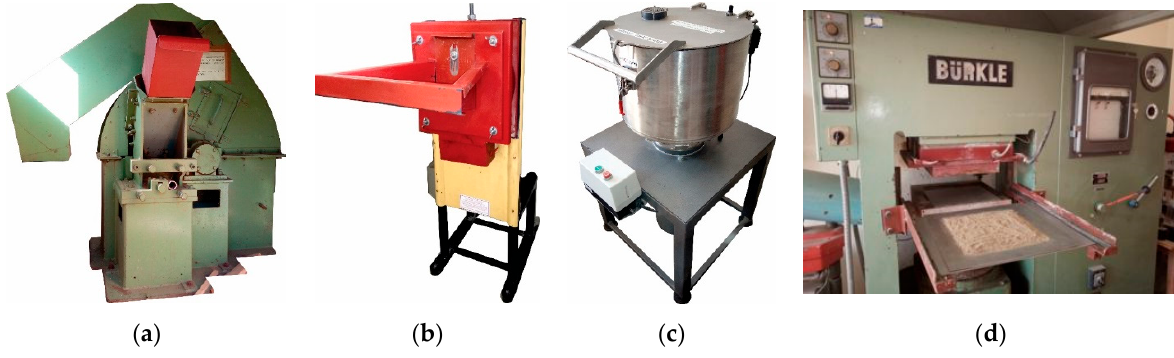
Figure 2. ( a ) Knife chipper, ( b ) hammermill, ( c ) custom-built blender, and ( d ) hydraulic press.